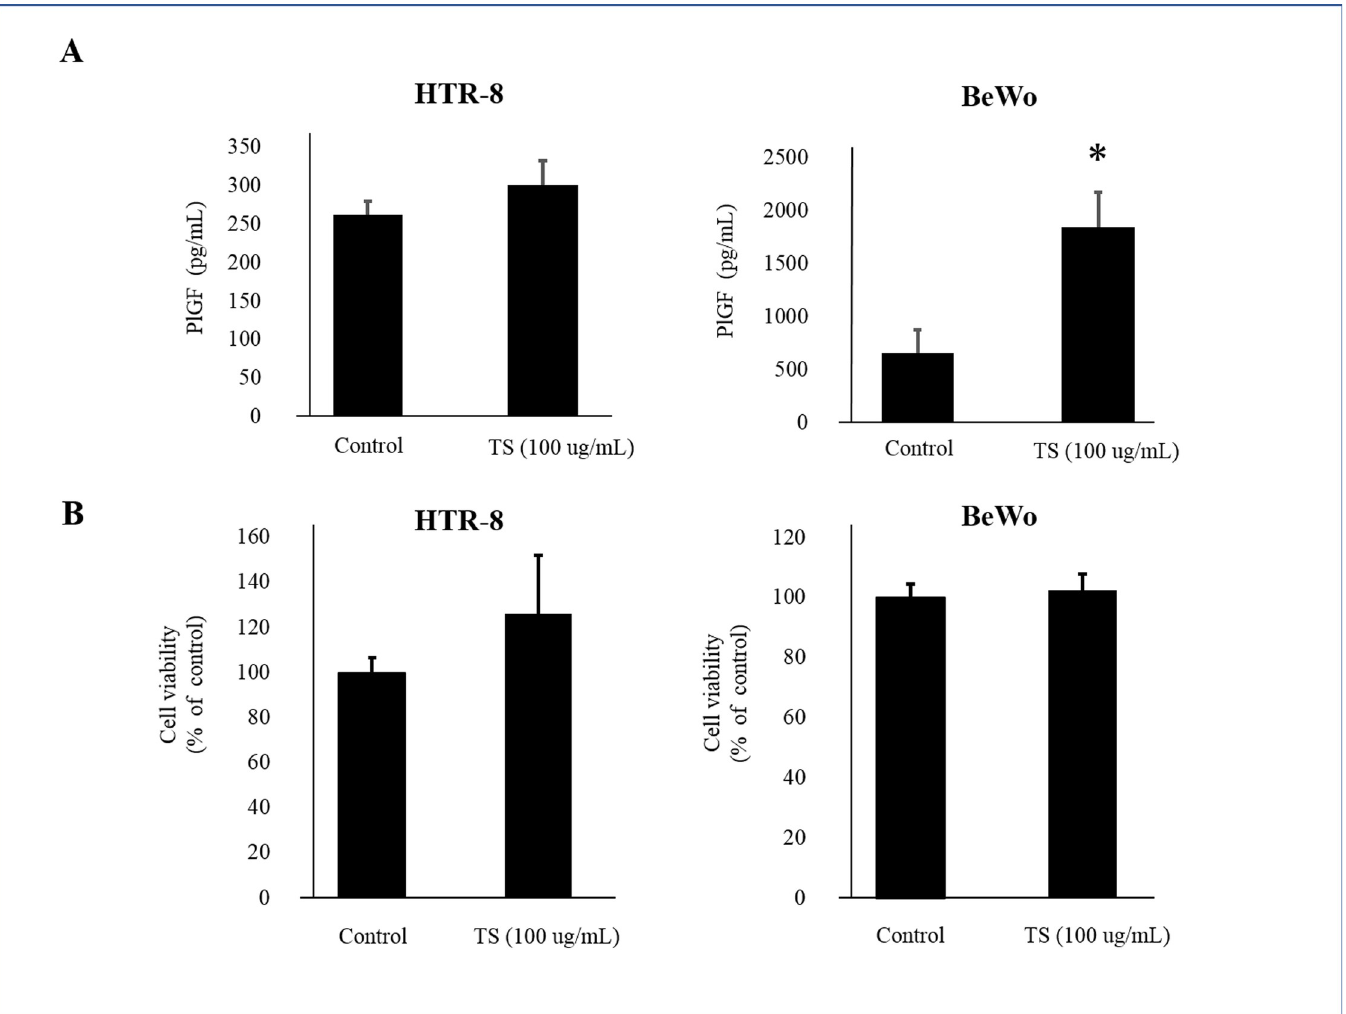
Fig 6. Effect of TS on PlGF expression and the cell viability of trophoblastic cells. A: PlGF concentrations produced by TS from HTR-8/SVneo and BeWo cells. B: The CCK-8 assay with TS in HTR-8/SVneo and BeWo cells. � indicates P < 0.05. TS, Tokishakuyakusan; PlGF, placental growth factor; HTR-8, HTR-8/SVneo cells; BeWo, BeWo